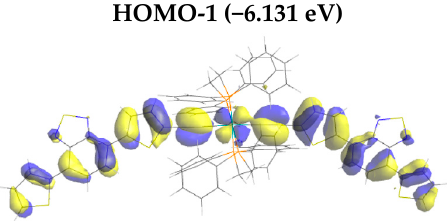
Figure 3. Molecular orbital (MO) pattern of the MO’s related to the major one-photon absorption (OPA) transitions of Ru-1 . Calculated at the B3LYP/6-31G(d) (lanl2DZ for Ru) level in the vacuum.